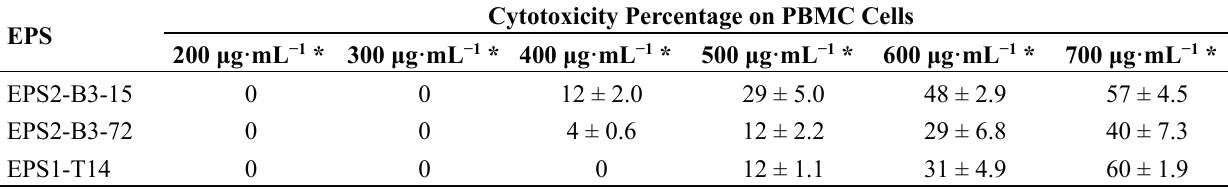
Table 4. Cytotoxicity percentage on PBMC cells 48-h post-EPSs treatments. Values represent the means of three experiments